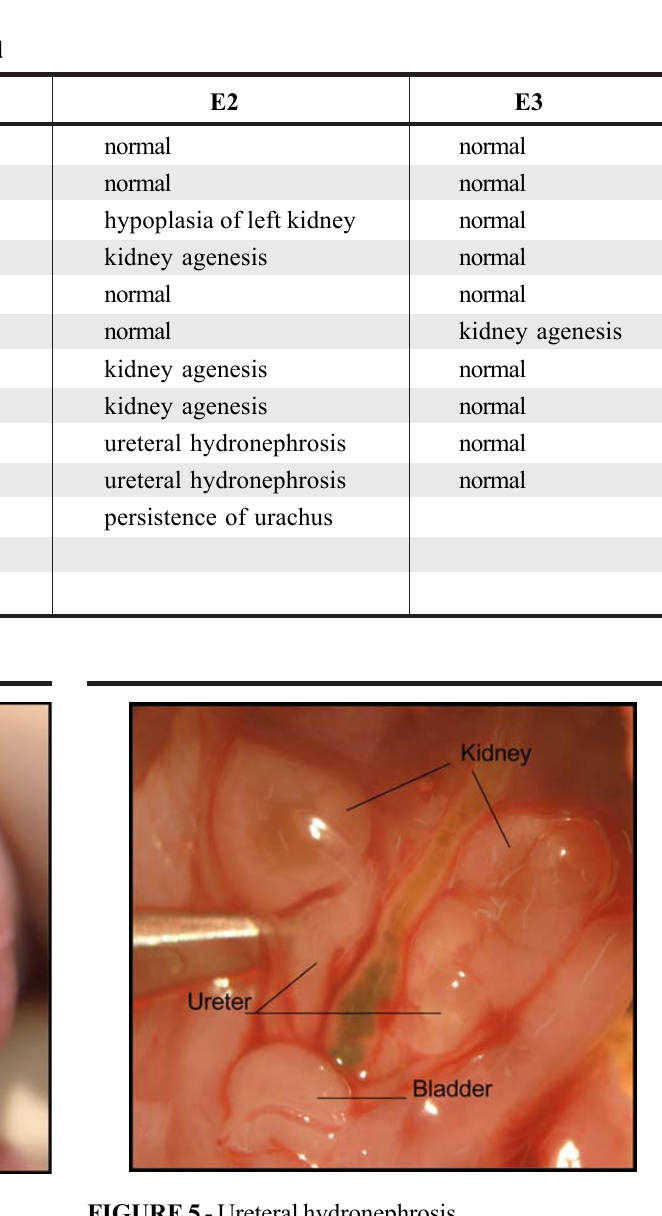
FIGURE 4 - Tail agenesis FIGURE 5 - Ureteral hydronephrosis